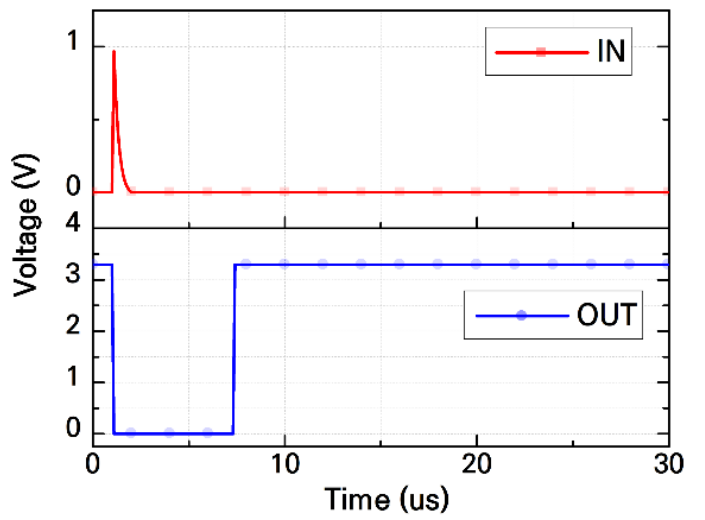
Figure 6. Functional verification simulation of the proposed pulsed radiation detection circuit.